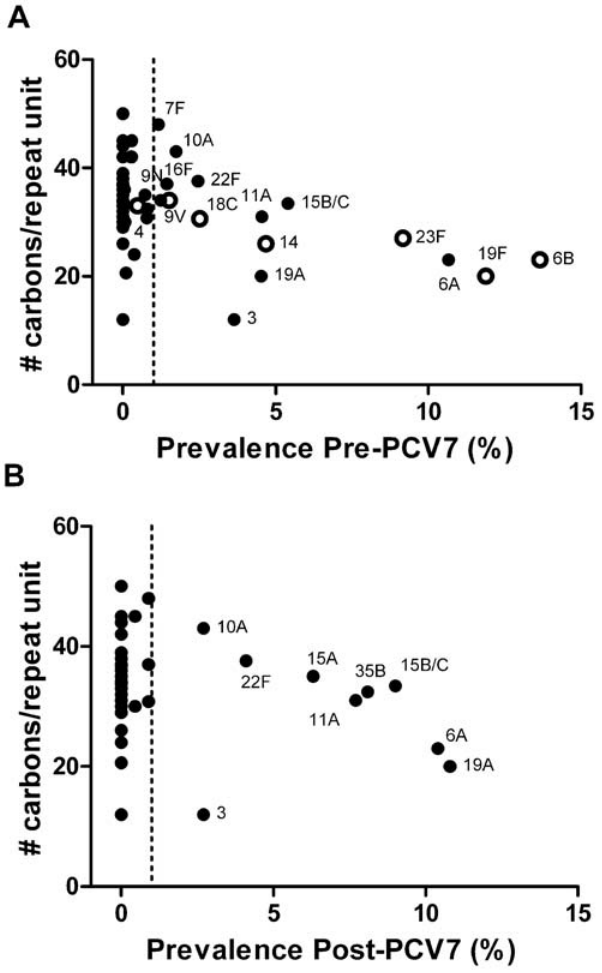
Figure 4. Relationship between capsule structure (carbon/ repeat unit) and carriage prevalence [ 44 ] . Capsule structure is associated with prevalence both A) before introduction of conjugate vaccine ( r = 2 0.80, p , 0.001, excluding type 3) and B) after introduction of vaccine (2004) among children in Massachusetts ( r = 2 0.90, p , 0.05, excluding type 3). Vaccine types are denoted by an open